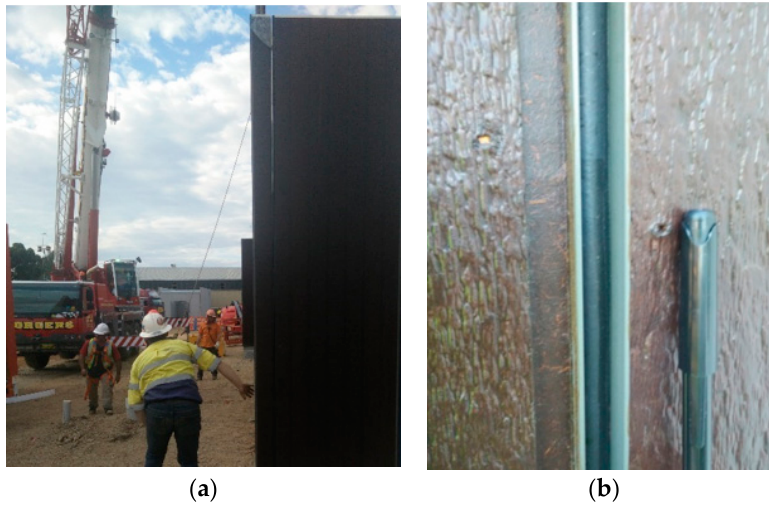
Figure 17. Lifting and placement of panels: ( a ) Complete prefabricated wall panels are lifted and place into position whilst compressing the rubber gasket; ( b ) Due diligence in measurement of gap width and assessment of shape and embedment depth.